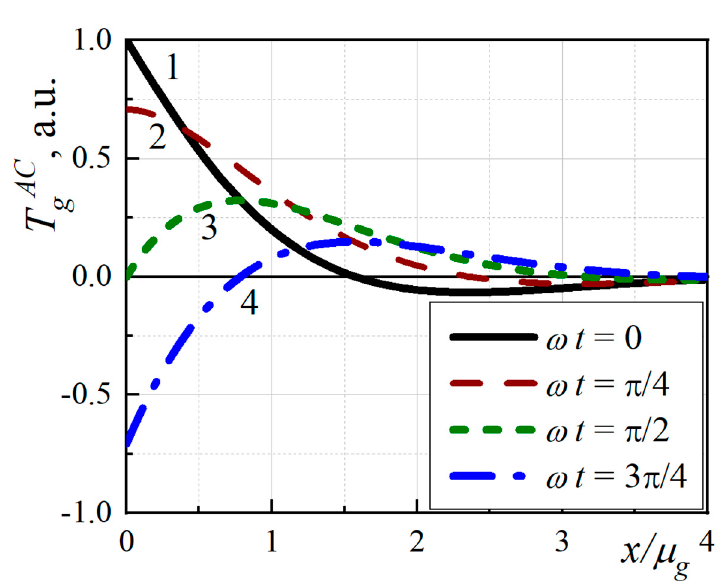
Figure 2. Spatial distribution of the variable component of temperature perturbation (𝑇 (cid:3034)(cid:3002)(cid:3004) ) in the gas layer adjacent to the sample’s surface: ω t = 0 (1), ω t = π / 4 (2), ω t = π / 2 (3), and ω t = 3 π / 4 (4) .